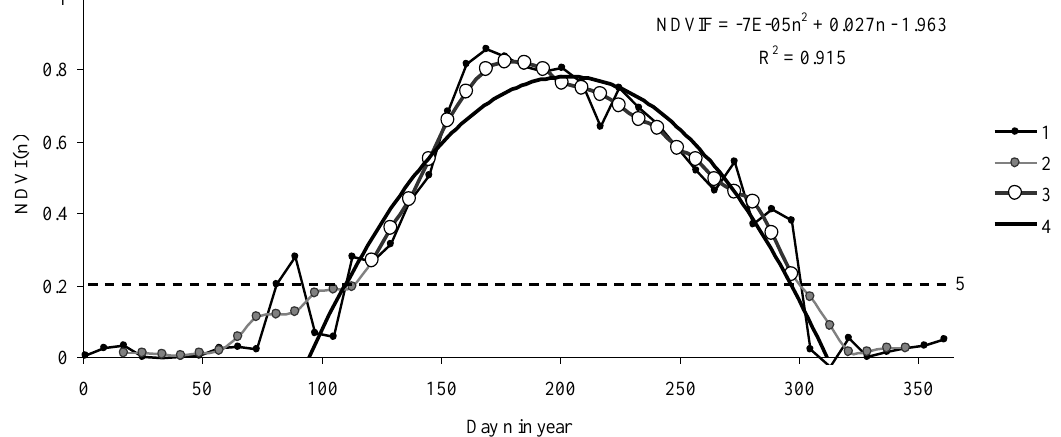
Figure 2. A typical NDVI (n,i) time series (where n is the number of the day in a year; i is the number of the year, study area no. 4, meadow, i = 2003). ( 1 ) a seasonal time series of NDVI, ( 2 ) filtered series 1 , ( 3 ) series 2 clipped at critical value NDVIF crit = NDVIF min + 0.2(NDVI max − NDVI min ), ( 4 ) parabolic approximation of series 3 ; ( 5 ) critical value of NDVI (n).